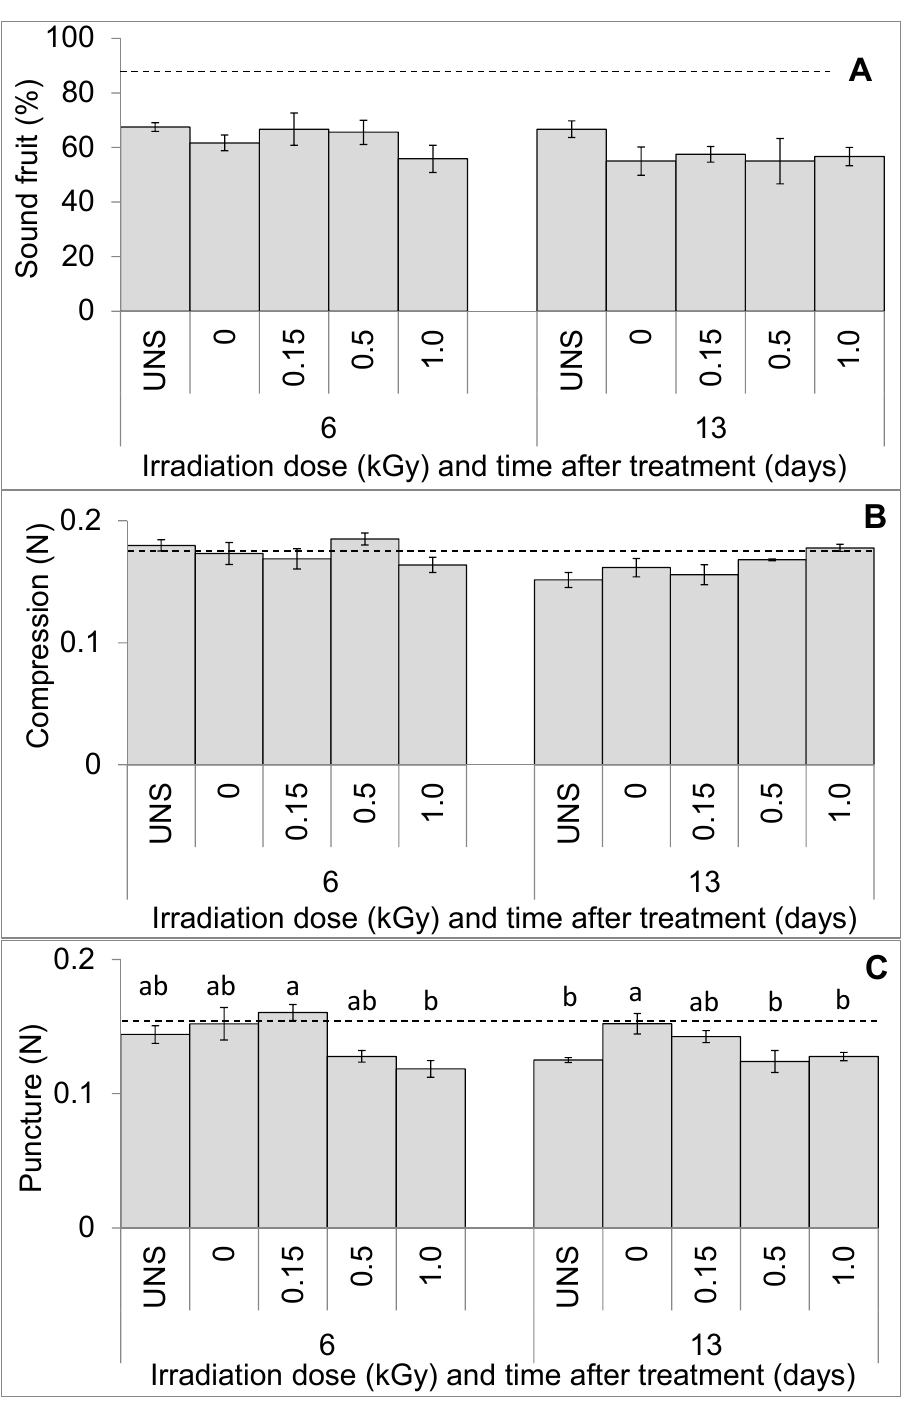
Figure 3. Effect of Electronic Cold-Pasteurization TM on percent sound fruit ( A ), compression ( B ), and puncture ( C ) for ‘Rebel’ blueberries in trial 2. Treatments included an unshipped control (UNS; not shipped to the irradiation facility) and four levels of irradiation; no irradiation control (0), 0.15, 0.5, and 1.0 kGy. Evaluations were conducted 6 and 13 days after irradiation treatment. Fruit were stored at 2 to 4 °C under high relative humidity until assessments were performed. An initial fruit quality assessment was performed after harvest shown as a horizontal dashed line. Means within the same storage times after treatment followed by the same letter are not significantly different from each other based on one-way analysis of variance ( α = 0.05).